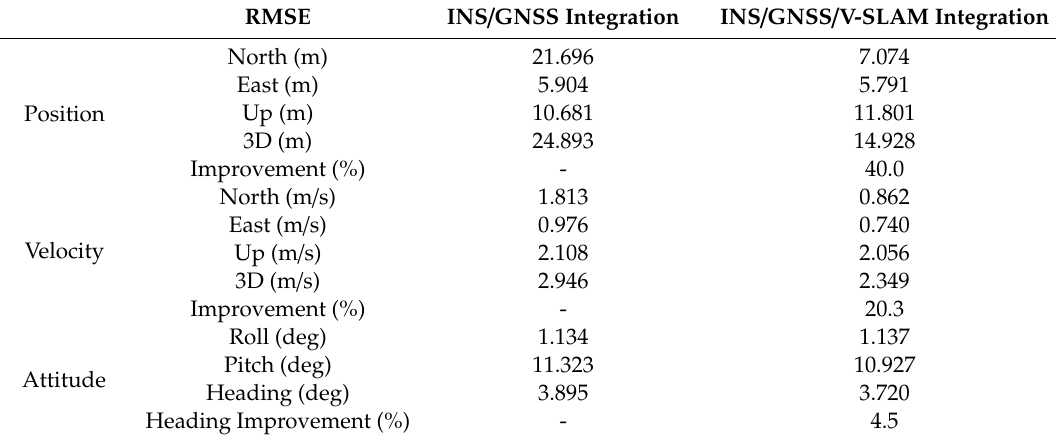
Figure 14. Graphical comparison of navigation errors with planned GNSS outages in the first test. Table 4. Statistical summary of navigation errors with planned GNSS outages in the first test.